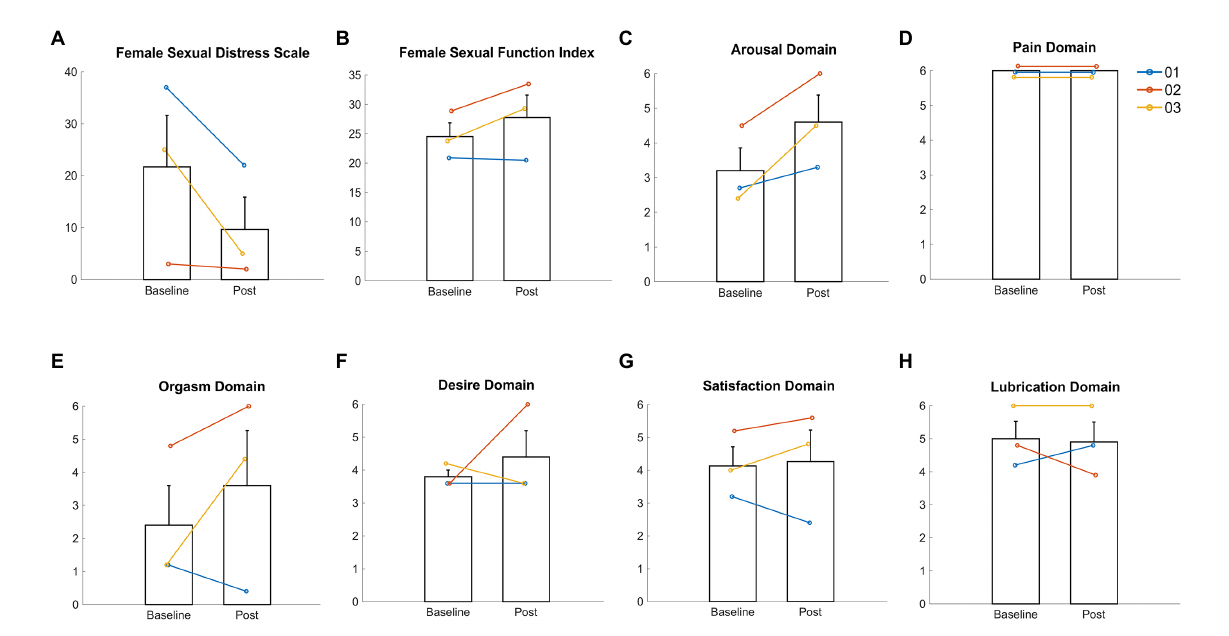
FIGURE 2 Female sexual distress and sexual function in three female participants with thoracic sensorimotor complete SCI. (A) Female sexual distress measured by the Female Sexual Distress Scale; (B) Total sexual function measured by the Female Sexual Function Index (FSFI); (C) Arousal domain of the FSFI; (D) Pain domain of the FSFI; (E) Orgasm domain of the FSFI; (F) Desire domain of the FSFI; (G) Satisfaction domain of the FSFI; (H) Lubrication domain at FSFI; Bar plots represent the mean scores at baseline and post-intervention; Errors bars represent the standard deviation; Individual participant responses presented by coloured lines: 01 (blue); 02 (red); 03